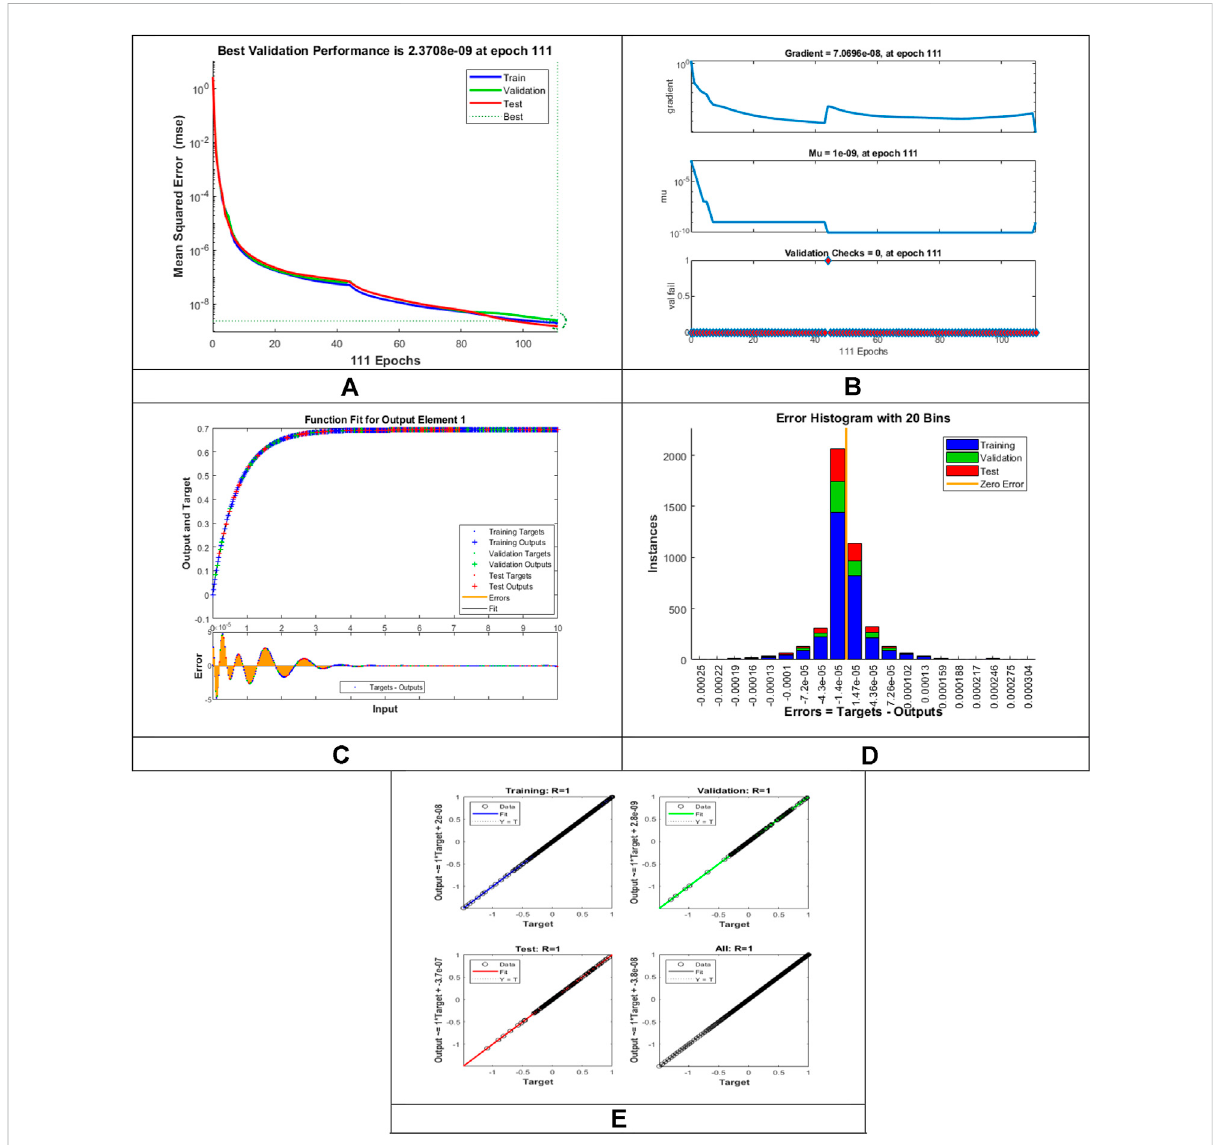
FIGURE 6 PictorialillustrationfortheLMLA-BPNN baseonvariantsof λ vsf ′ ( η ) forMHD-WNF-HGA. (A) M-S-Edemonstration, (B) transitionstateanalysis, (C) curve fi tting, (D) error histogram, and (E) regression